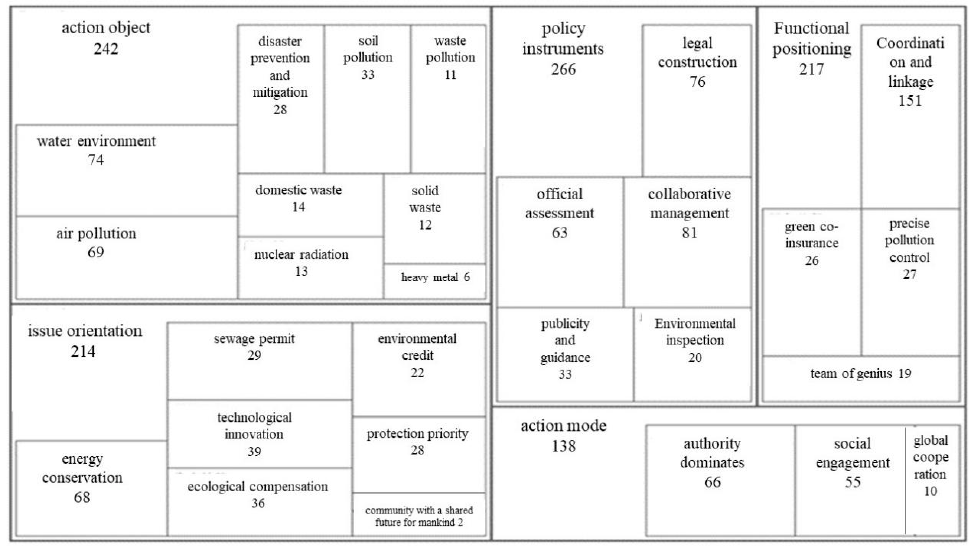
Figure 2. Node coding level and the set of reference points.